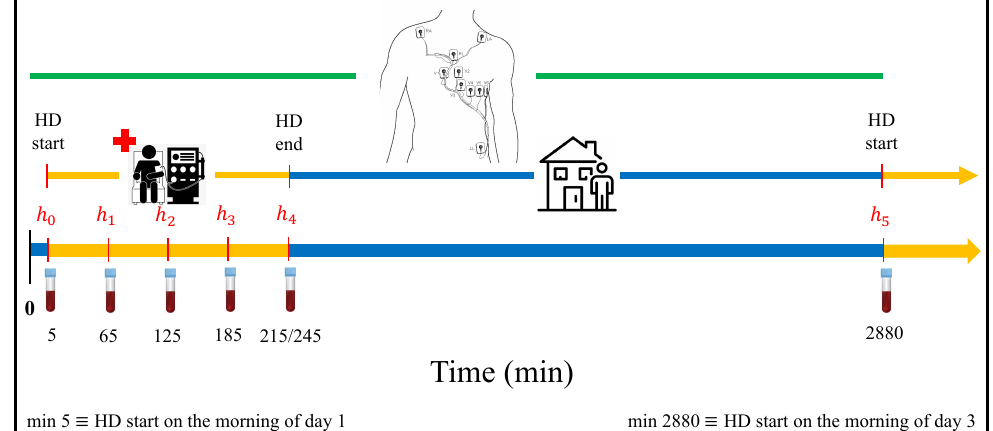
Figure 1. Data acquisition protocol. Holter electrocardiogram (ECG) signals of end-stage renal disease patients undergoing hemodialysis (ESRD-HD) patients were acquired throughout 48 h, starting 5 min before the beginning of the HD therapy. Six blood samples were collected at the beginning of the therapy ( h 0 ), each hour during the HD ( h 1 , h 2 , h 3 ), at the end ( h 4 , at minute 215th or 245th, depending on the HD duration) and before the beginning of the next HD session ( h 5 ).